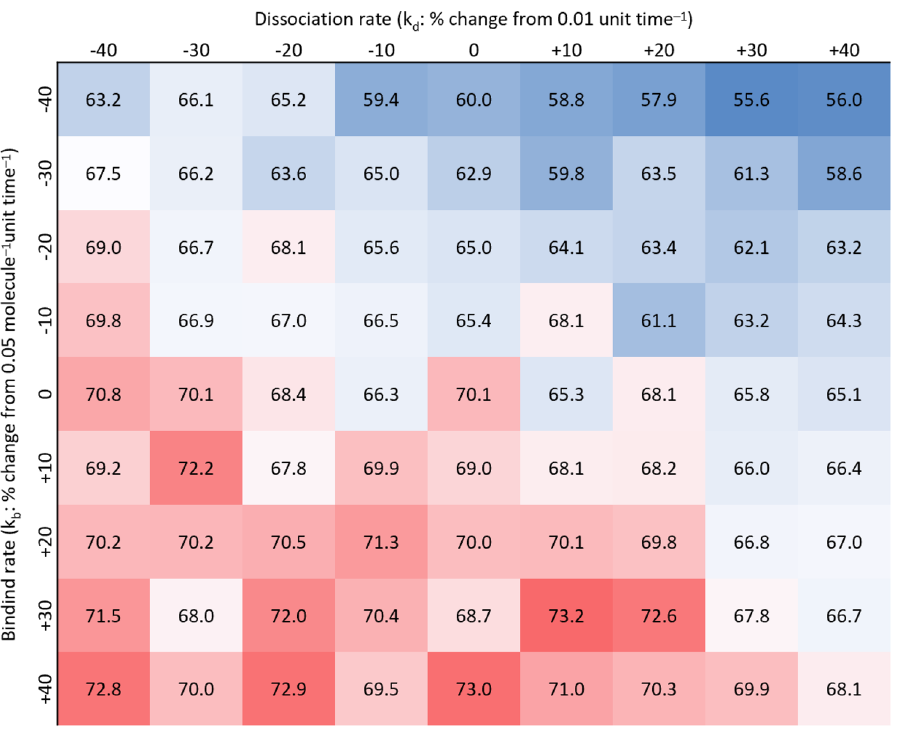
Figure 12. Increase in binding rate and decrease in dissociation rate increase GPVI dimerisation. Simulation varying the binding and dissociation rate value from −40%, −30%, …, + 30%, + 40%, deviating from the initial values of k b = 0.05 molecule –1 unit time –1 and k d = 0.01 unit time –1 . Values represent percentages of GPVI in dimeric form, as a proportion of total GPVI. Red colour represents higher dimerisation, blue lower